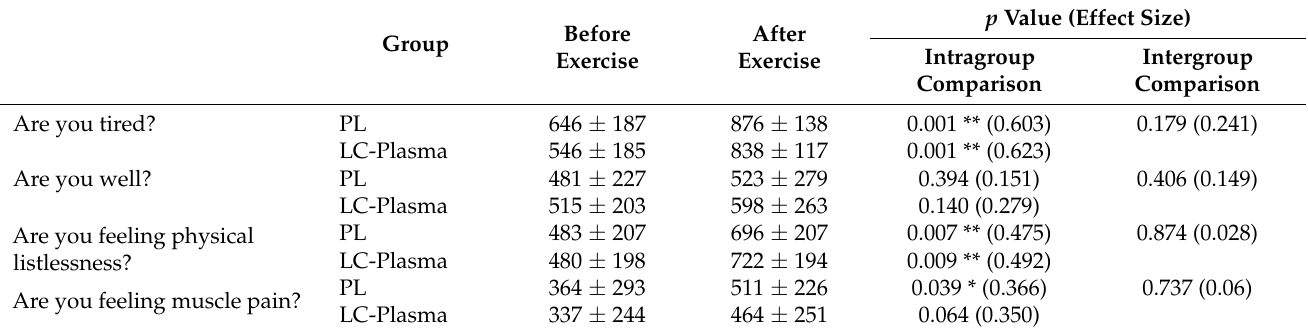
Table 7. Hematological and physiological indices related to fatigue after single exercise. Day 15 Group